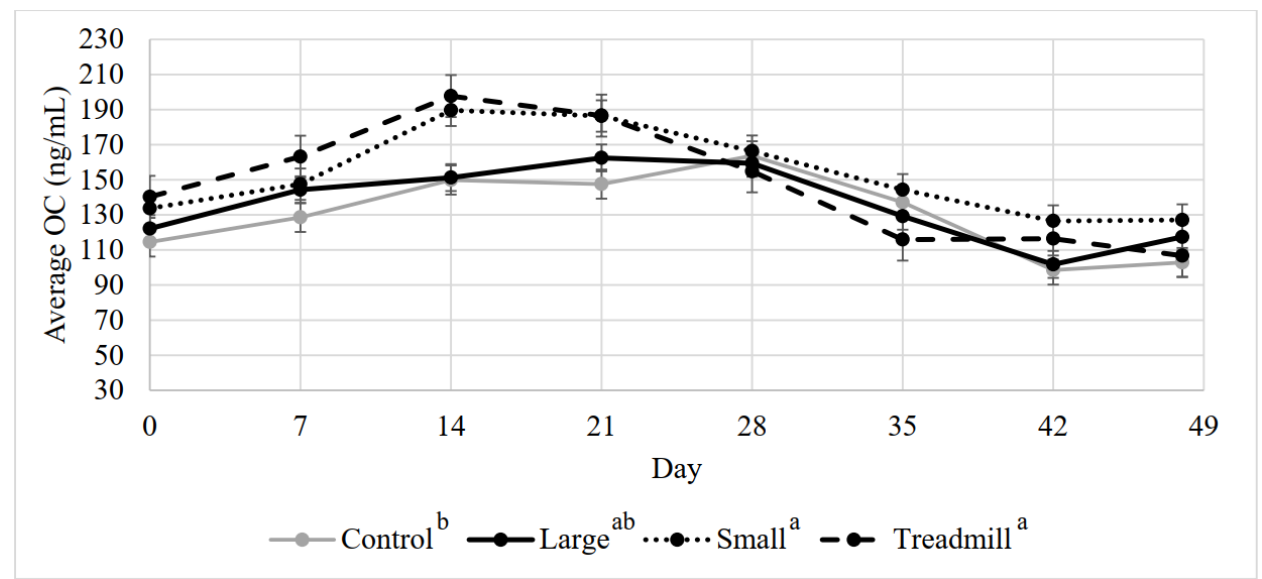
Figure 1. Mean calf serum osteocalcin (OC) by treatment throughout the 7-week study period . a, b Treatments lacking common superscripts differ ( p =